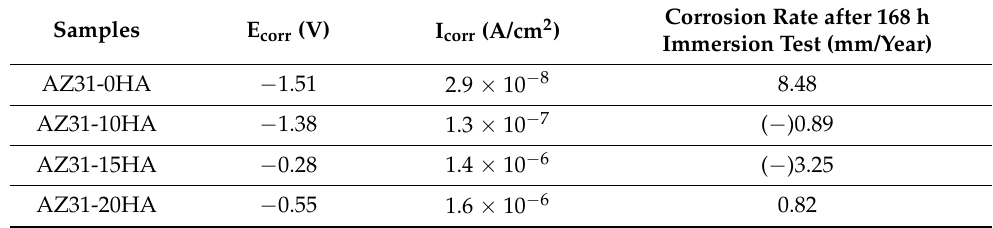
Figure 12. EDX analyses; electron mapping of elements present at AZ31-15HA BMMC surface after immersion test in HBSS at 37 ± 2 °C for 168 h. Table 4. Corrosion potential, corrosion current density and corrosion rate of BMMCs in